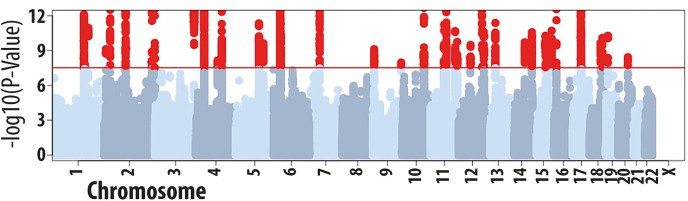
Summary of results from the GWAS of allergic disease age-of-onset in the UK Biobank study (n = 117,130).UK Biobank participants reported age-of-onset for asthma and, in a single separate question, for hay fever/eczema. In this analysis, we took the earliest age-of-onset reported across these two questionnaire items and tested this phenotype for association with SNP allelic dosage. We identified 4,160 variants associated with age-of-onset at a P<3x10-8 (red circles), including 50 with a statistically independent association.